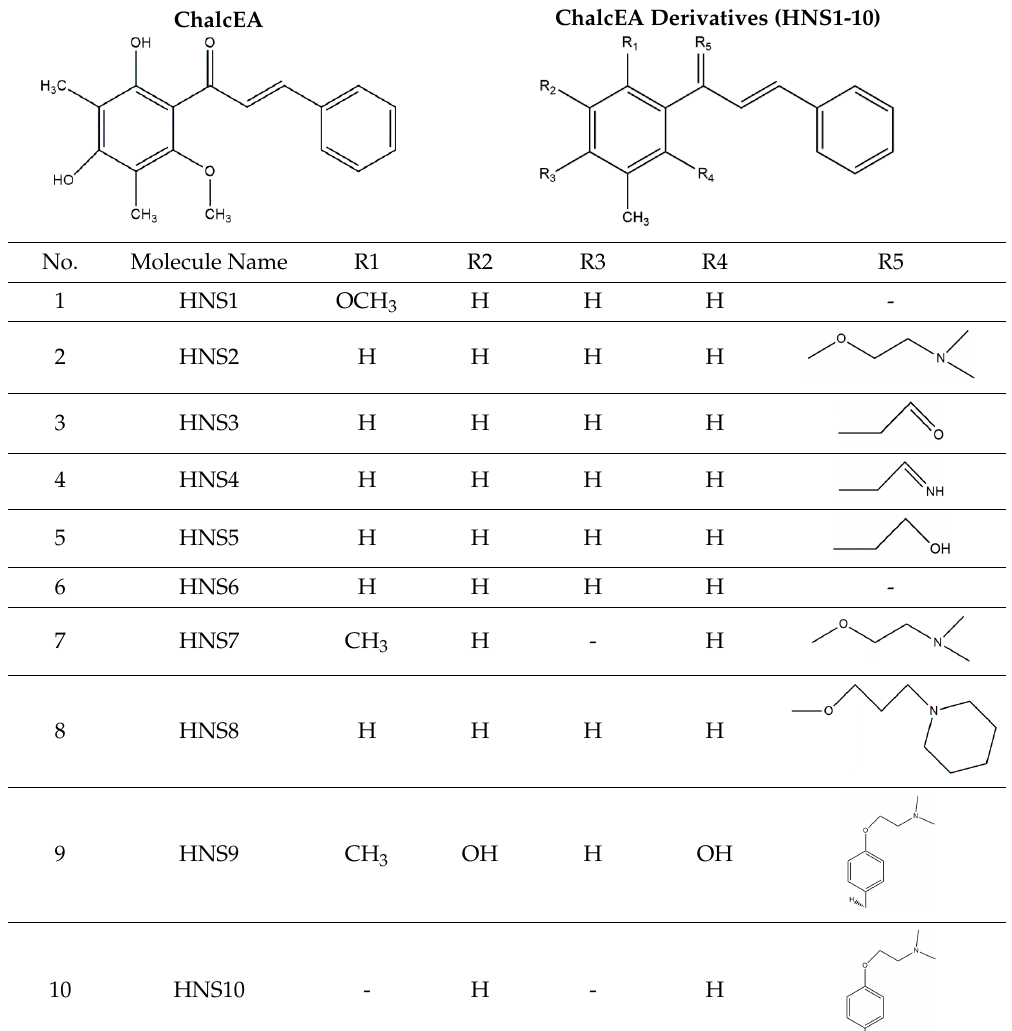
Table 1. Derivatives of 2 ′ ,4 ′ -dihydroxy-6-methoxy-3,5-dimethylchalcone (ChalcEA). ChalcEA ChalcEA Derivatives (HNS1-10)